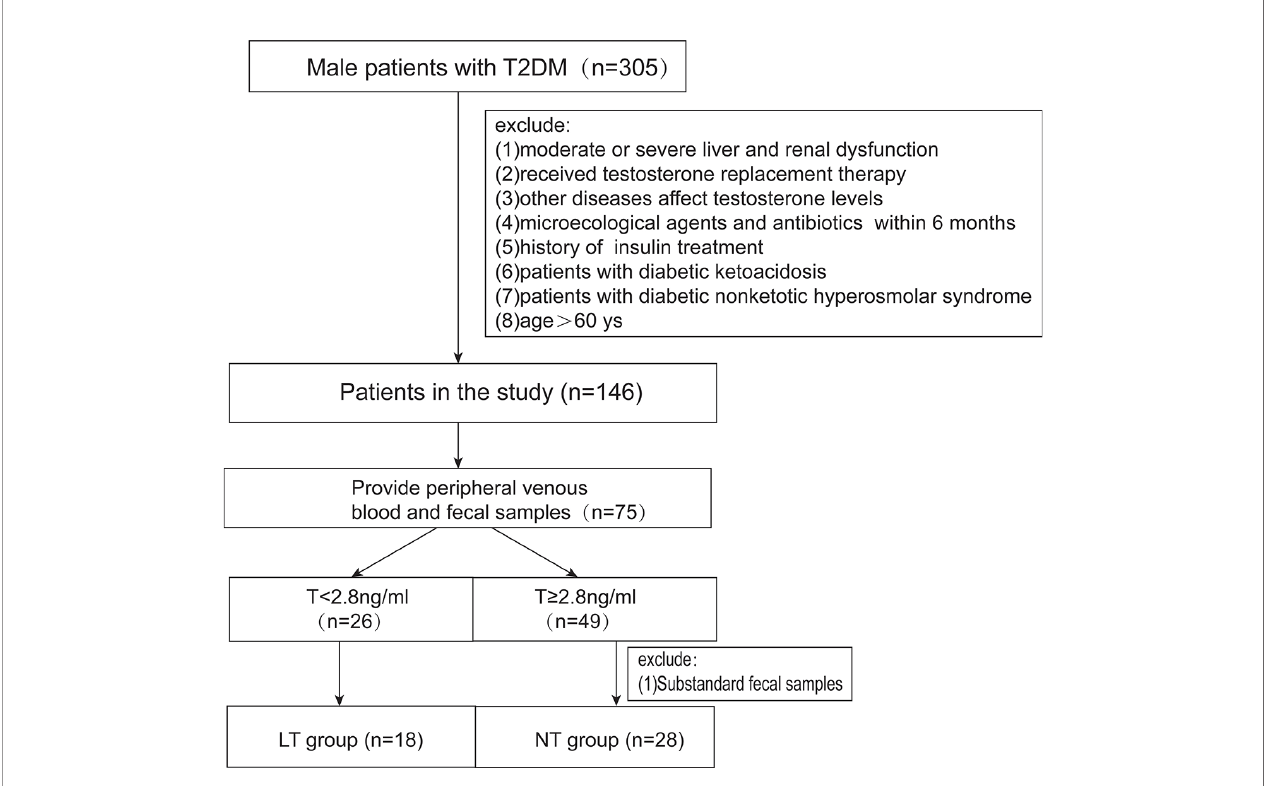
FIGURE 1 | The schematic diagram of this